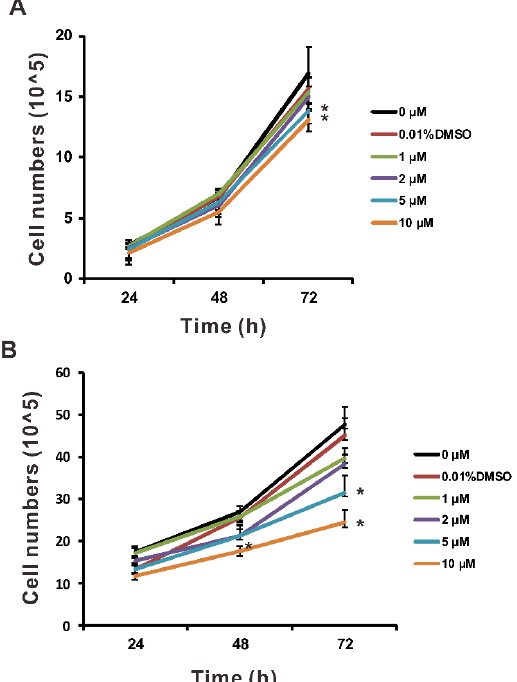
Figure 2. Antiproliferative effects of coriloxin on lung cancer cells. The proliferation activity of ( A ) A549 and ( B ) CL1-5 cells ( n = 6 per group) treated with coriloxin for 24, 48, or 72 h was examined. Each experiment was performed, at least, in triplicate, and the values were reported as mean ± SD. * p < 0.05 indicates a significant difference from the solvent control group (0.01%